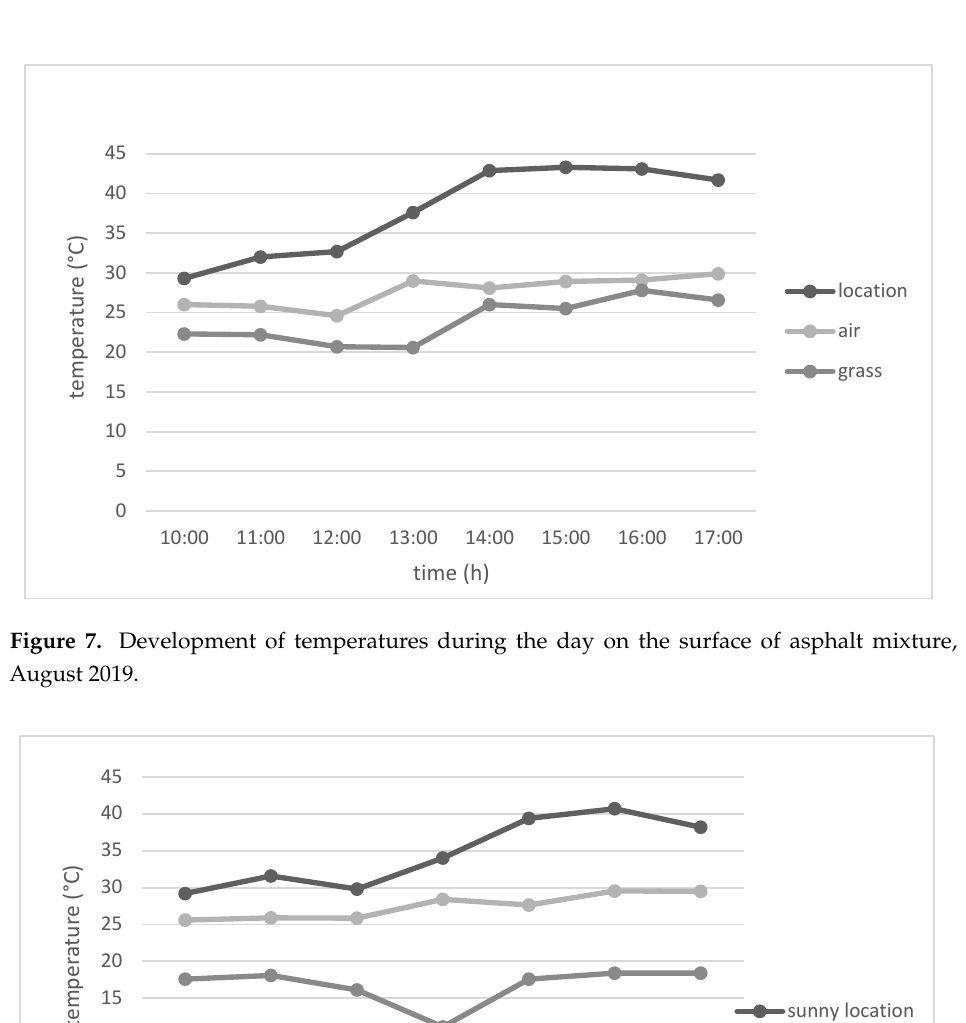
Figure 6. Development of temperatures during the day on a sunny/partial shaded surface of as-